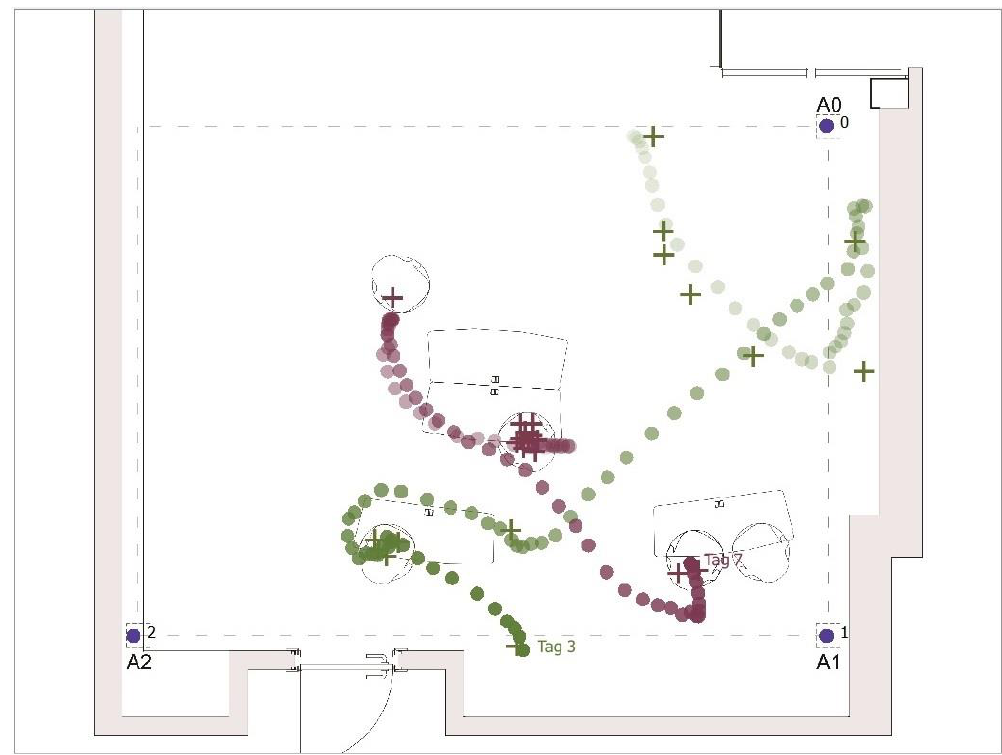
Figure 10. Behavior map representing the live capture of the location of two people captured by two tags and three anchors placed on a custom-developed ceiling system.